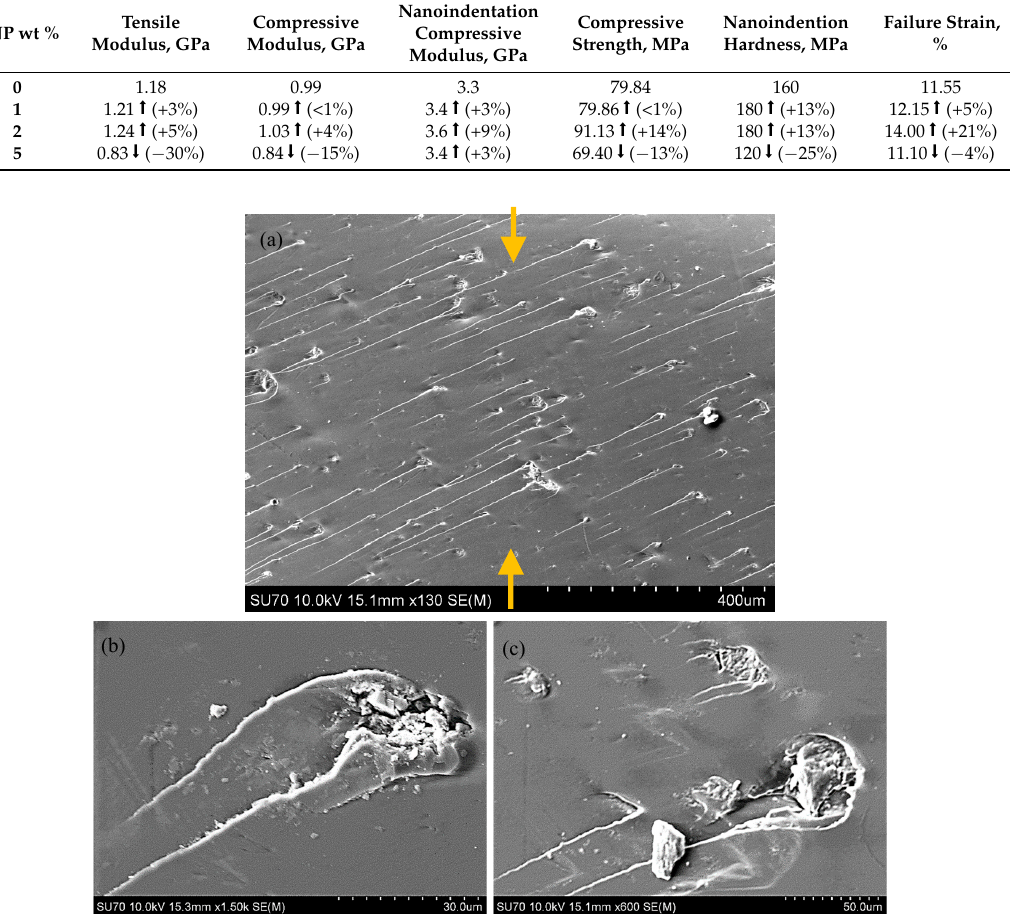
Figure 13. Stress concentration induced microcracks surrounding CNPs in specimens under compression loading; ( a ) microcrack coalesce over a region of 1000 × 700 microns (arrows represent the direction of the compressive load), ( b , c ) magnified images of microcracks over regions of 80 × 60 microns.